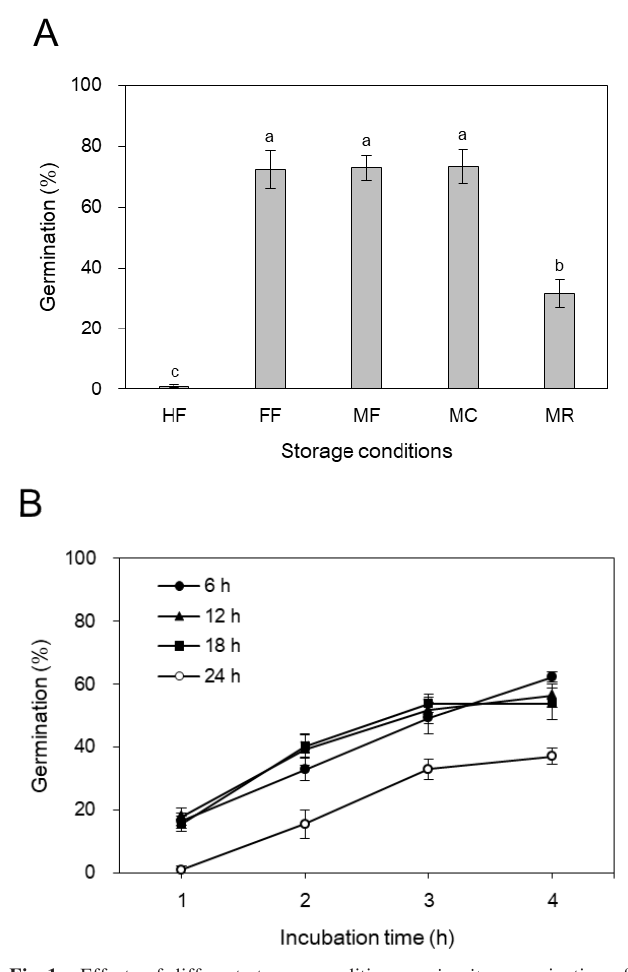
Fig. 1: Effects of different storage conditions on in vitro germination of kiwifruit pollen. Pollen germination was observed following five storage conditions (A) or after various durations of RT exposure (B). HF, heat-treated frozen storage; FF, fresh frozen storage; MF, moisture-treated fro- zen storage; MC, moisture-treated cold storage; MR, moisture-treat- ed RT storage. Different letters on the error bars indicate significant differences based on Tukey’s Studentized range at p ≤ 0.05. Error bars represent the SE of mean values ( n =